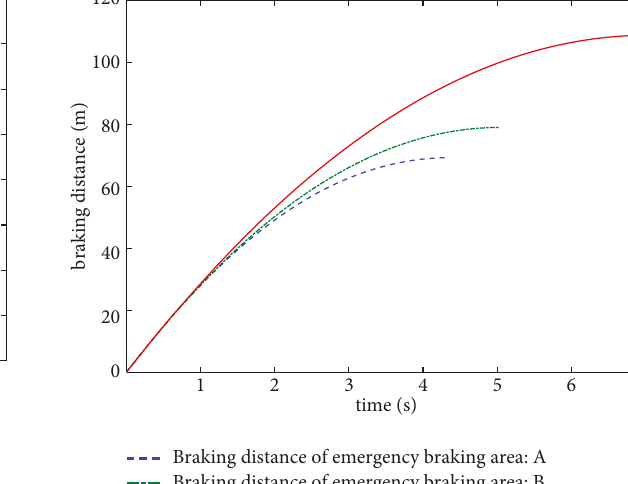
Figure 7: Braking distance in emergency area.